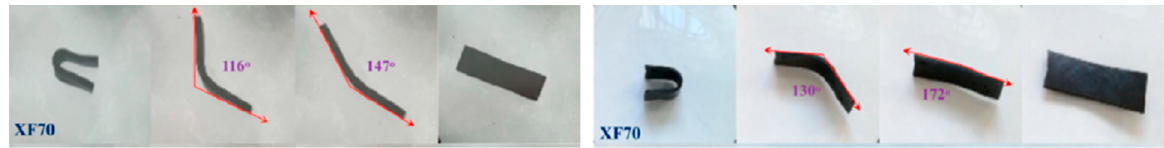
Figure 5. ( Left ) shape memory activated by a heated environment, ( right ) shape memory activated by an AC magnetic field [29].